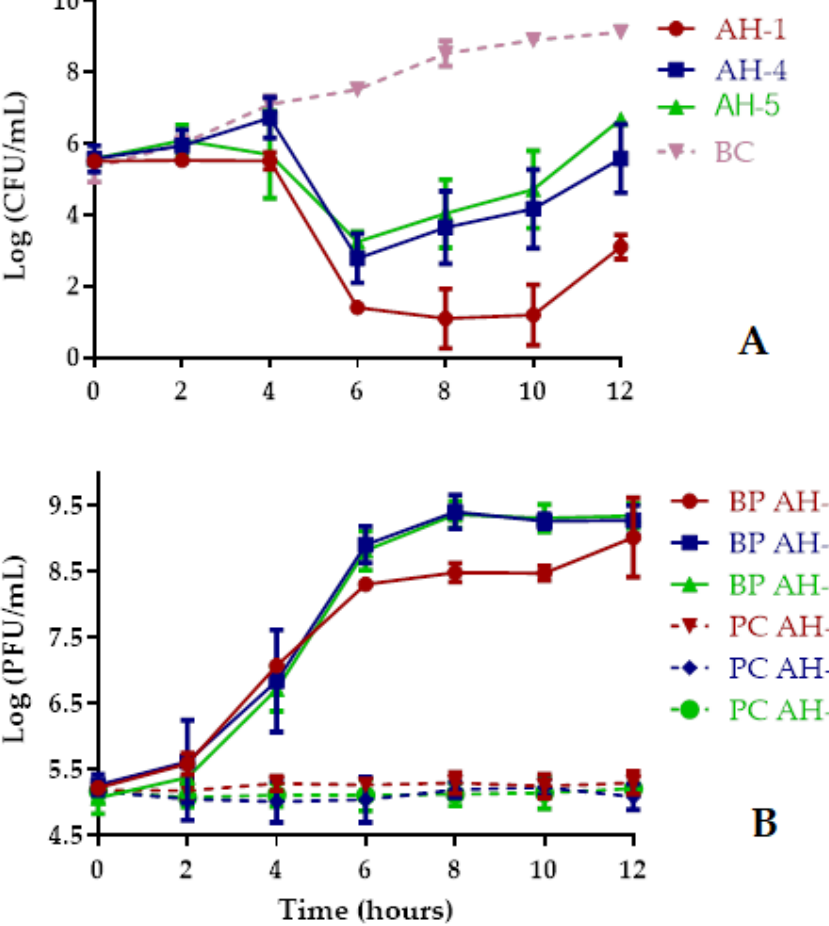
Figure 3. Inactivation of A. hydrophila by the three phages (AH-1, AH-4, and AH-5) during 12 h using an MOI of 1. ( A ) Bacterial concentration: BC, bacteria control; BP, bacteria plus phage. ( B ) Phage concentration: PC, phage control; BP, bacteria plus phage. Values represent the mean of the three experiments and error bars represent the standard deviation.